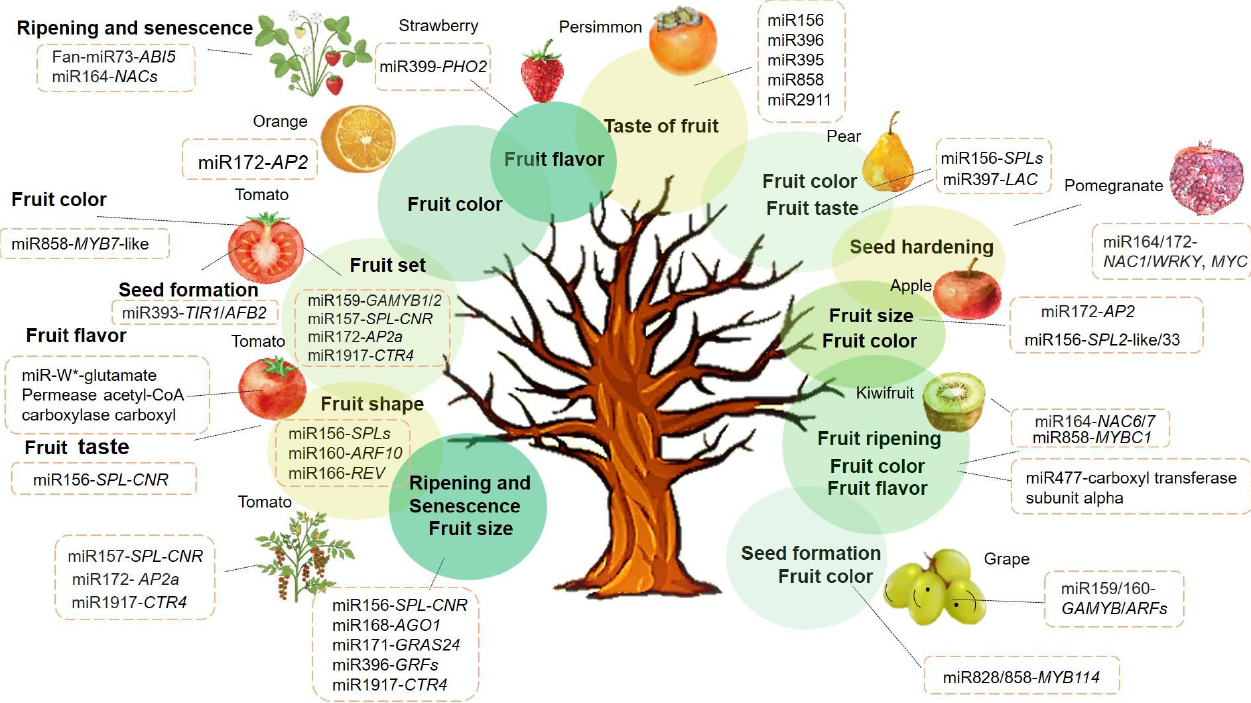
Figure 1. The main microRNA pathways—fruit development, size, color, shape, taste, flavor, ripening, and senescence—are divided into seven categories and are represented by a cartoon fruit tree. MicroRNA-integrated pathways are denoted in bold, while species- or lineage-specific pathways are denoted in circle.